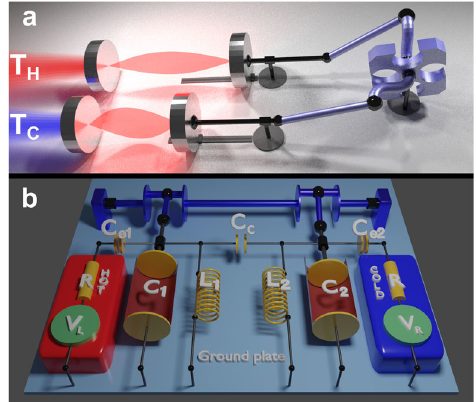
Fig. 1 Schematic representations of our thermal motor. a A schematic photonic circuit connected to two thermal baths at different temperatures, T T H > C , that is able to divert part of the thermal radiative energy into useful work in the form of the motion of a mechanical degree of freedom (MDF) described by a rotor. b An electromechanical motor consisting of two LC resonators, with grounded inductances L 1(2) and capacitances C 1(2) , connected via a coupling capacitance C c . The two thermal baths are represented via Thevenin equivalent transmission lines, with characteristic impedance R and grounded voltage sources V L(R) , and they are attached to the circuit via capacitances C e 1( e 2) . The capacitance plates of the LC resonators are coupled to pistons whose motion is out-of-phase with one another, thus exercising a torque to a rotor. When the system operates in the vicinity of exceptional points (EPs) and violates speci fi c spatiotemporal symmetries (or the baths are subjected to spectral fi ltering), the motor operates at optimal thermal averaged force is